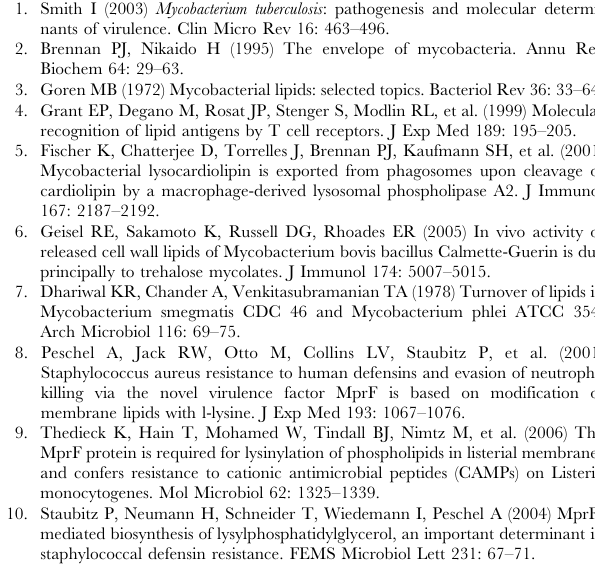
counting. The bars represent mean 6 standard error. Figure S2 Visualization of Fl-Van stained cells. Actively growing cultures (optical density , 0.01 to 0.04) were grown with fluorescent vancomycin BODIPY (Invitrogen) at a final concen- tration of 1 m g/mL for 20 hours. The cells were harvested by low speed centrifugation, fixed in 4% paraformaldehyde for 24 h, and imaged on a Nikon Eclipse microscope with a CCD camera; bright field (BF) and fluorescent images (Van) were acquired. Magnification was 100 6 , and data were analyzed using Meta- morph software. At least 100 cells were imaged for each strain; the images were scored for staining patterns and the presence or absence of fluorescent staining. Approximately 35% of wild type and 25% of lysX cells were not stained under these conditions. For clarity, only select staining patterns are shown: defined dye accumulation at the cell poles -A, D- and mid-cell (as in D) or diffuse accumulation throughout the cell - B, E. In some cells, both types of accumulation were observed -C, F. For the lysX mutant, about 52% of cells showed diffuse staining, but this was only seen in about 32% of wild type cells. Figure S3 Effect of SDS on the viability of the lysX mutant: The viability of Mtb strains was examined under the same conditions used for macrophage infection and lysis in the presence of 0.09% SDS. Actively growing cultures of Mtb strains were harvested, exposed to 0.09% SDS for 3 min, diluted and spread on Middlebrook 7H11 agar plates. Cells untreated with SDS were processed similarly. All plates were incubated at 37 u C, and